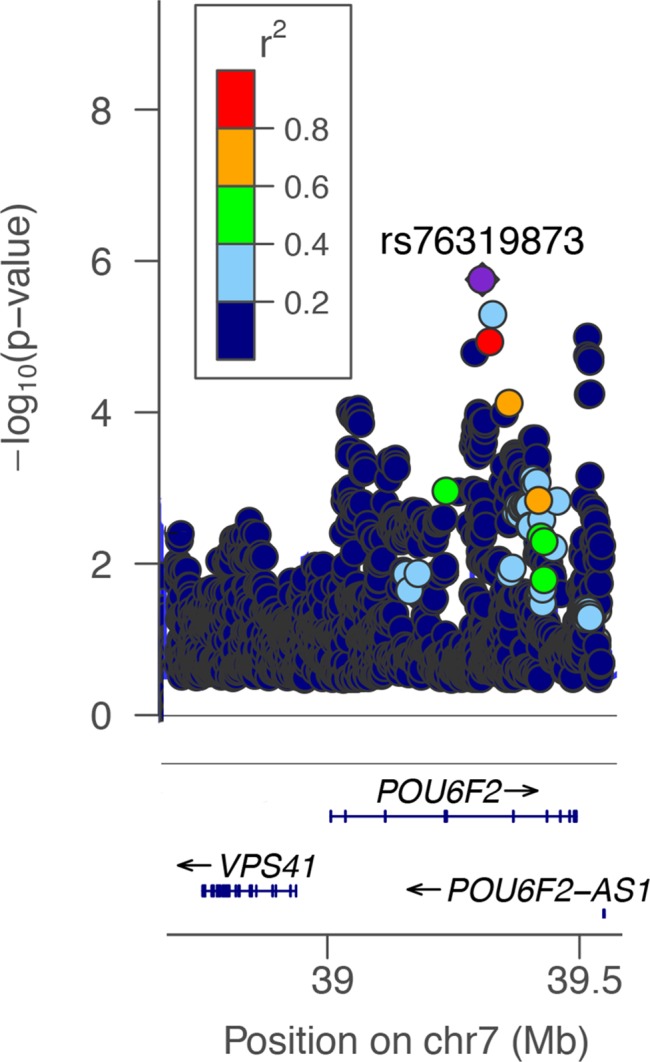
This is a Manhattan plot over the locus containing POU6F2.To the left is the p value related to glaucoma in a log10 scale. On the bottom portion of the panel the location of three human genes is shown: VPA41, POU6F2 and Pou6F2-AS1. The SNP (rs76319873) with the highest association to POAG is colored purple. The panel insert denotes the imputed quality score (r2) and the appropriate SNPs are colored in the plot.